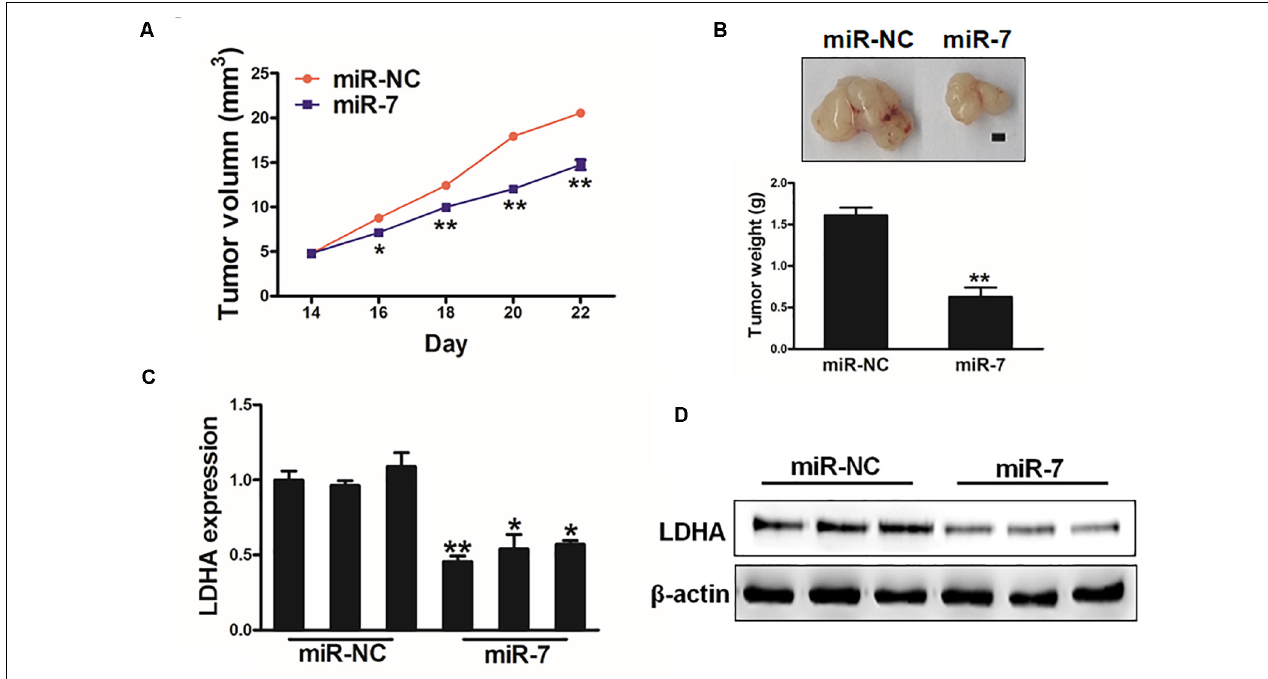
FIGURE 6 | MiR-7 impairs in vivo tumor growth. (A,B) A total of 5 × 10 6 BGC823 cells that had been stably transduced to express miR-7 or miR-NC were implanted subcutaneously in nude BALB/c null mice, after which tumor volumes were assessed over time. After 24 days, tumors were collected and weighed, revealing a lower weight for miR-7 overexpressing tumors. Scale bar = 1 mm. (C,D) LDH-A expression was decreased in miR-7 overexpressing tumors relative to NC controls as assessed via qRT-PCR. * P < 0.05; ** P <